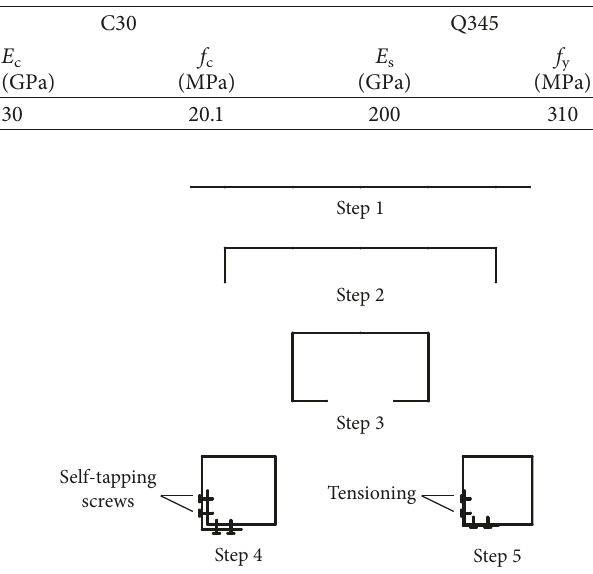
Figure 2: Manufacturing process of steel tubes.